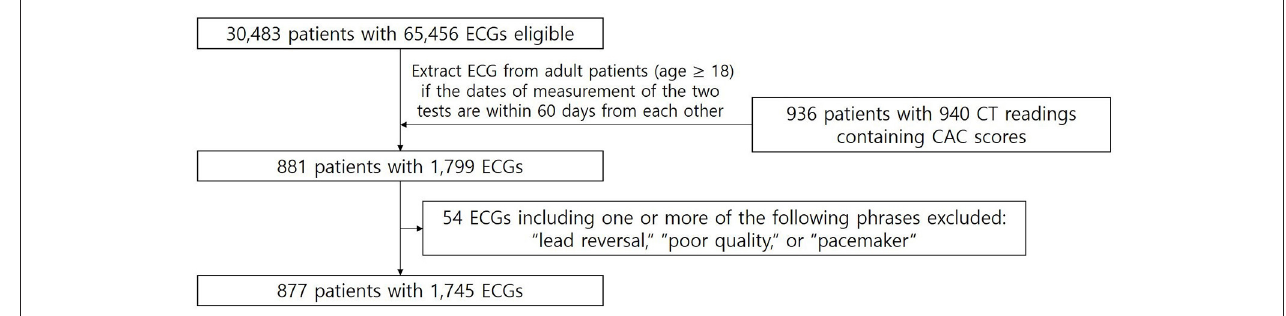
FIGURE 2 | Patient flow diagram of external validation dataset from YSH. From the YSH ECG database, after applying the exclusion criteria, the number of ECGs measured within 60 days before or after the CT readings containing CAC scores was 1,745 ECGs from 877 adult